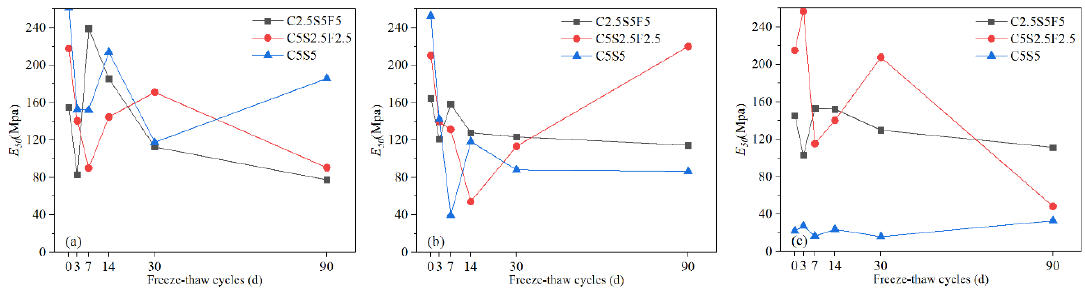
Figure 6. The E 50 values of Pb-CSCSs with the same compound binder and different contaminant contents: ( a ) C2.5S5F5; ( b ) C5S2.5F2.5, and ( c ) C5S5.